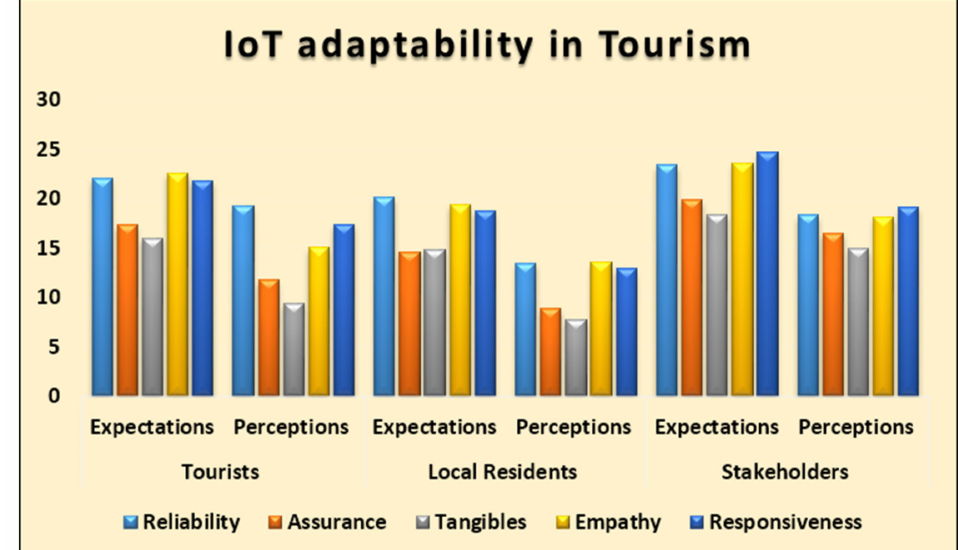
Figure 7. IoT adaptability in